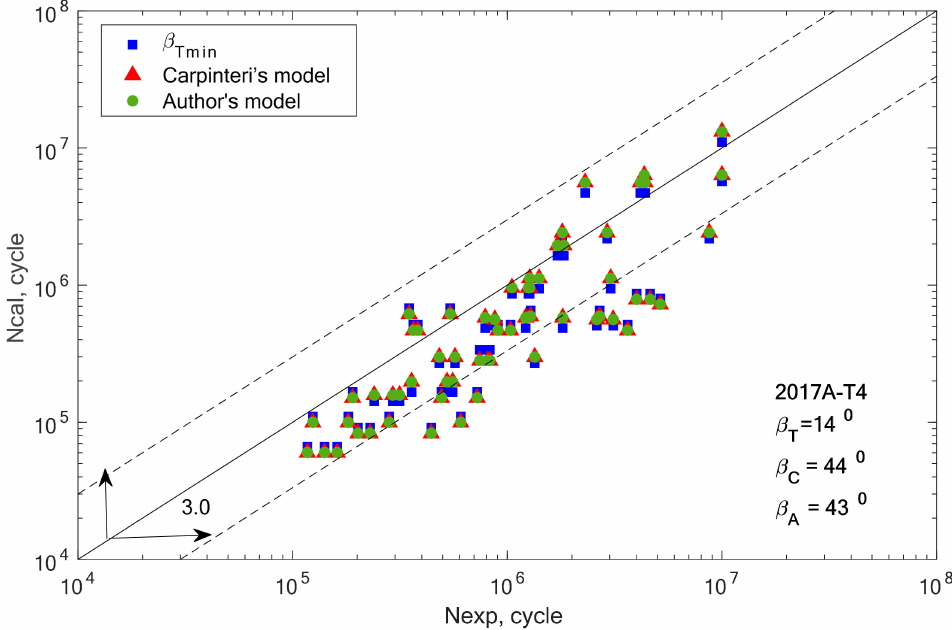
Figure 8. Comparison of the obtained design and experimental fatigue life for aluminium alloy 2017A-T4 for the cyclic bending–torsion combination.